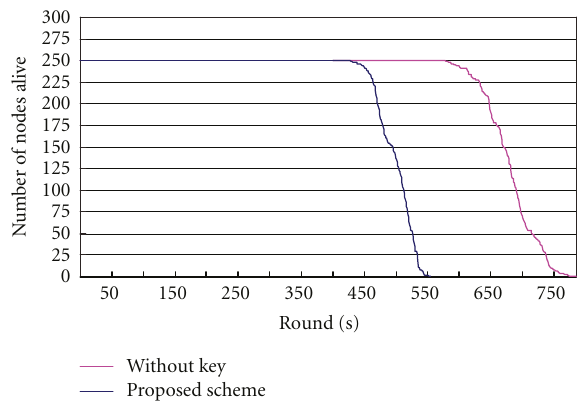
Figure 7: Number of survival nodes over